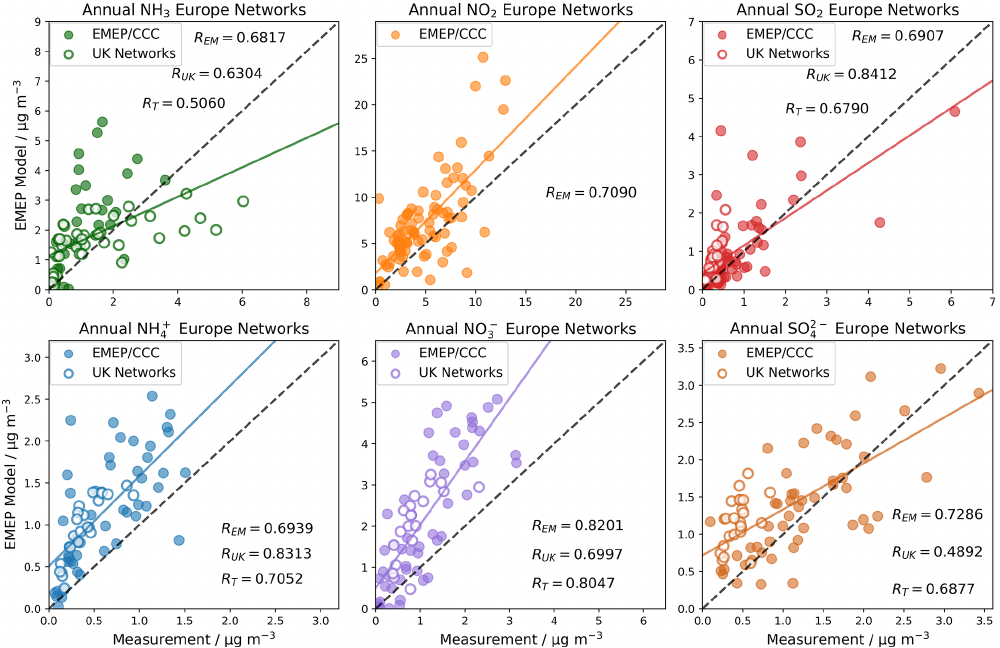
Figure 8. Scatter plots of 2015 annual mean modelled and measured NH 3 , NO 2 , HNO 3 , SO 2 , NH 4 + , NO 3 − , and SO 42 − concentrations at European monitoring network locations. In each plot, the solid line is the least-squares regression line and the black dashed line is the 1 : 1 line. R EM is for EMEP/CCC network. R UK is for UK networks. R T is the overall correlation coefficient between model and all measurements shown. Table 3. Summary statistics of model comparison with European measurements for 2015 (UK and EMEP/CCC networks). N is the number of paired data of models and observations. R T is Pearson’s coefficient for total measurements in EMEP/CCC and UK networks. Fac2 is the fraction of data points within a factor of 2. Mean_O and Mean_M are annual average concentrations (µgm − 3 ) of observation and model, respectively. NMB is normalized mean bias, and NME is normalized mean error. Species N R T Fac2 fraction Mean_O Mean_M NMB NME NH 3 77